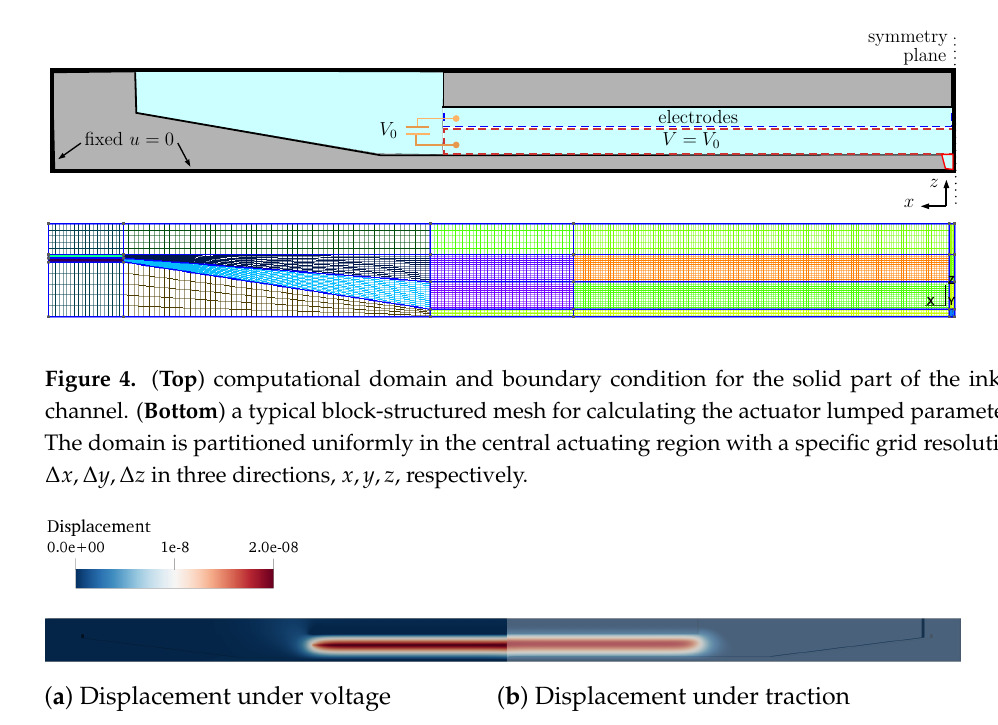
Figure 5. Displacement obtained from FEM analysis of the ink channel wall under ( a ) voltage and ( b ) pressure loading. The load is applied at the actuation boundary patch, as shown in Figure